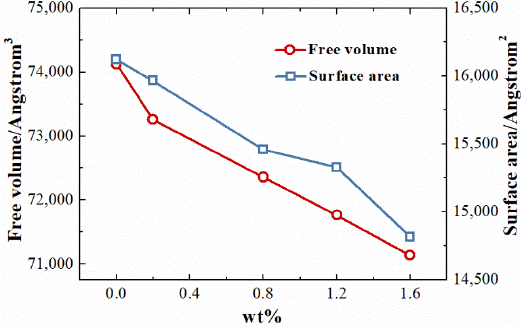
Figure 18. Free volume and surface area of the shale model with different water contents.